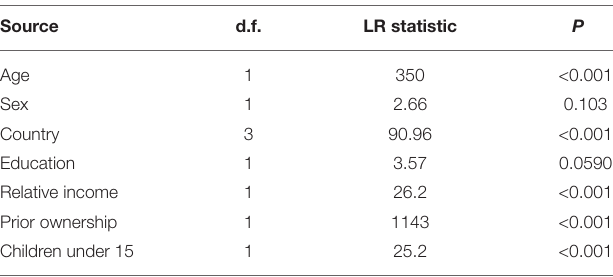
TABLE 2 | Factors affecting respondents’ stated likelihood of purchasing an exotic pet in the new 2